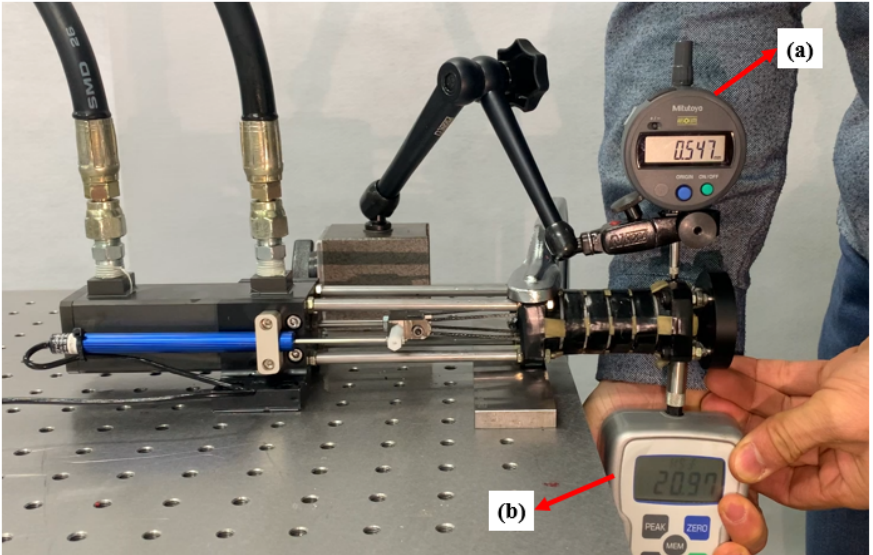
Figure 8. The experimental setup to measure various SJLM properties under the maximum tensile force: ( a ) an absolute Digimatic indicator to measure a displacement and ( b ) a push–pull gauge to measure a force applied to the